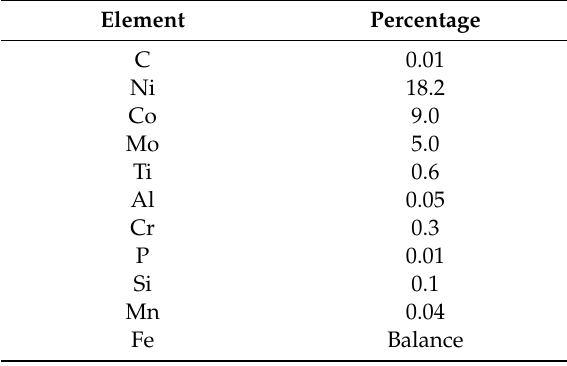
Table 1. Chemical composition of the 18Ni300 steel (weight